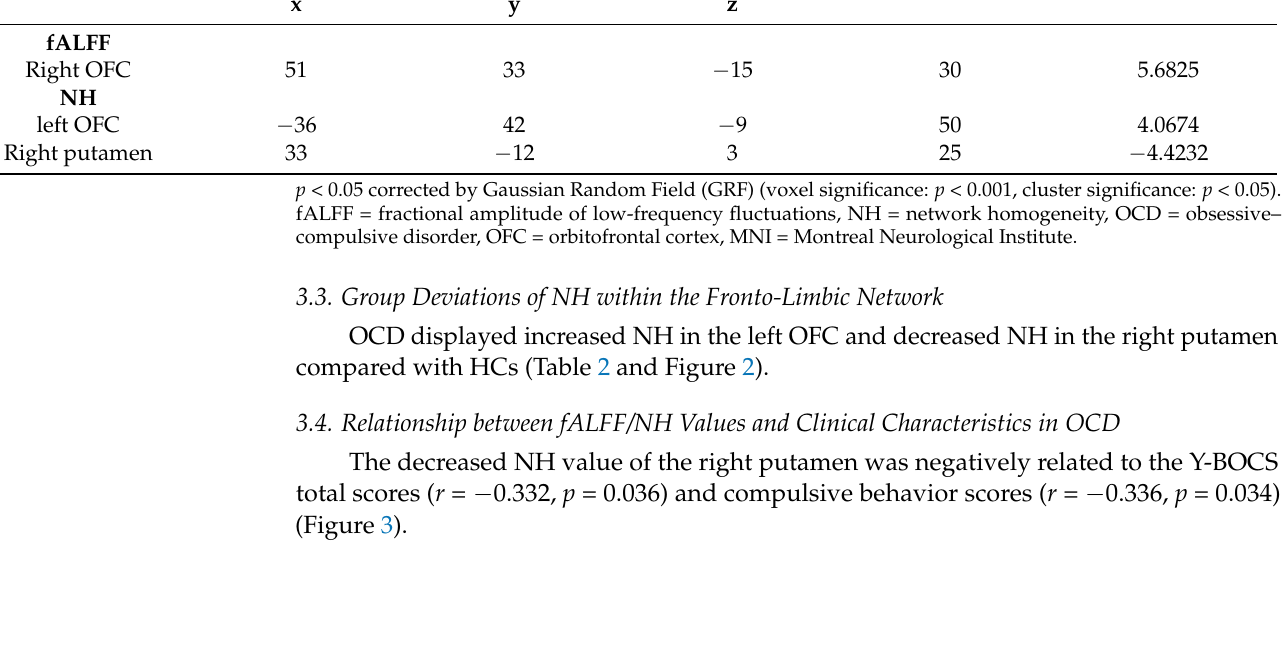
Table 2. Regions with altered fALFF/NH in fronto-limbic network at rest in OCD. Peak Cluster Location